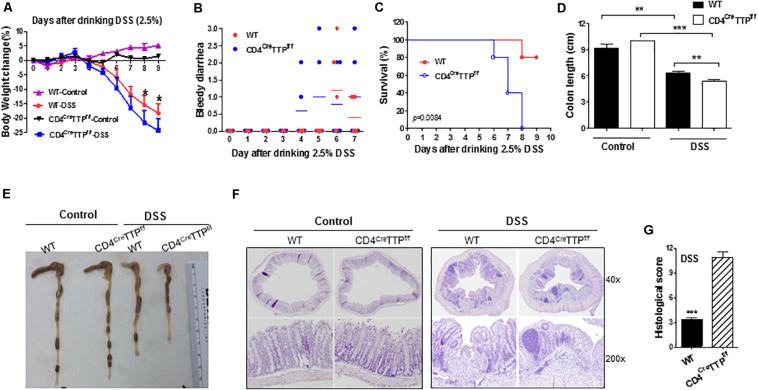
T cell-specific TTP conditional knockout mice are prone to DSS-induced colitis. Age- and body weight-matched CD4CreTTPf/f and control mice (8–12 weeks old) were administered with DSS in drinking water (2.5% wt/vol) for 5 days. Each group had five mice. Average body weight changes (A), bloody diarrhea (B), and survival (C) shown at indicated time points. On day 9, the lengths of colons of mice from treated groups were measured (D) and photographed (E). Sections of colons in each group were stained with hematoxylin and eosin (F). (G) Histological scores of colons collected from the above mice. Data are from four mice per group and represented as mean ± SD. *p < 0.05, **p < 0.01, and ***p < 0.001 between groups.